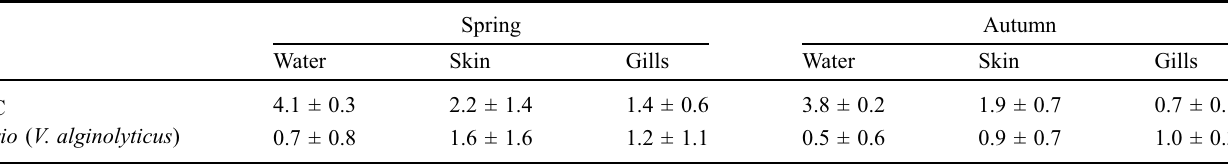
Max, maximum value; Min, minimum value; SD, standard deviation. Table 3. Heterotroph plate count (HPC) and Vibrio count in rearing sea water (logCFU/mL) and on skin and gills of Atlantic blue fi n tuna (logCFU/cm 2 ) in two